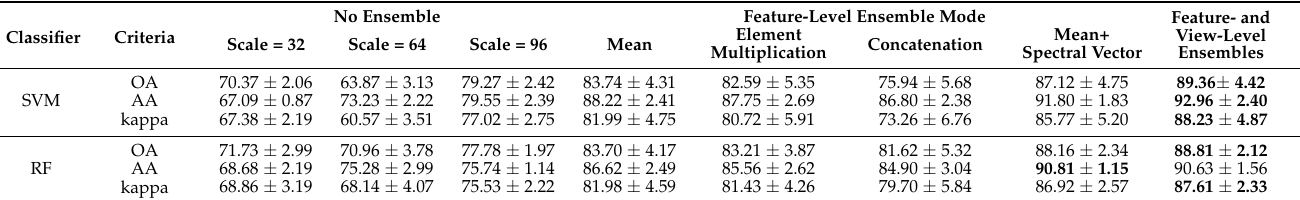
Table 8. The experimental designs and results of ablation